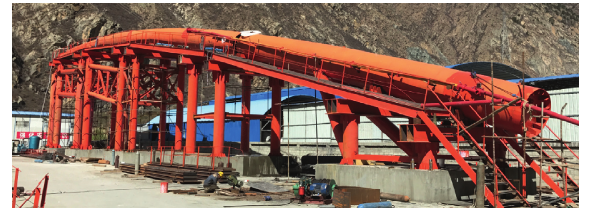
Figure 3: Actual photograph of test